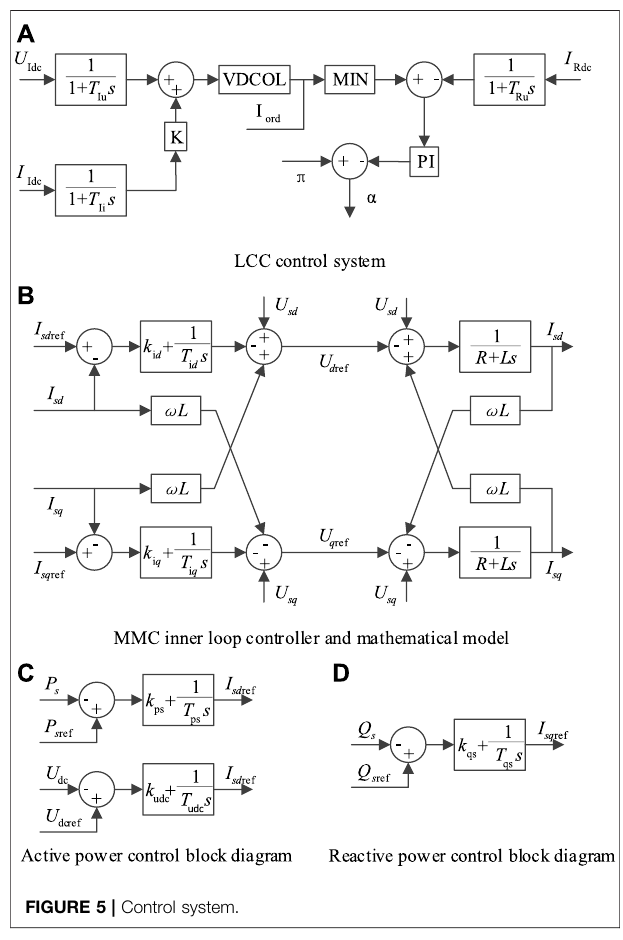
FIGURE 5 | Control